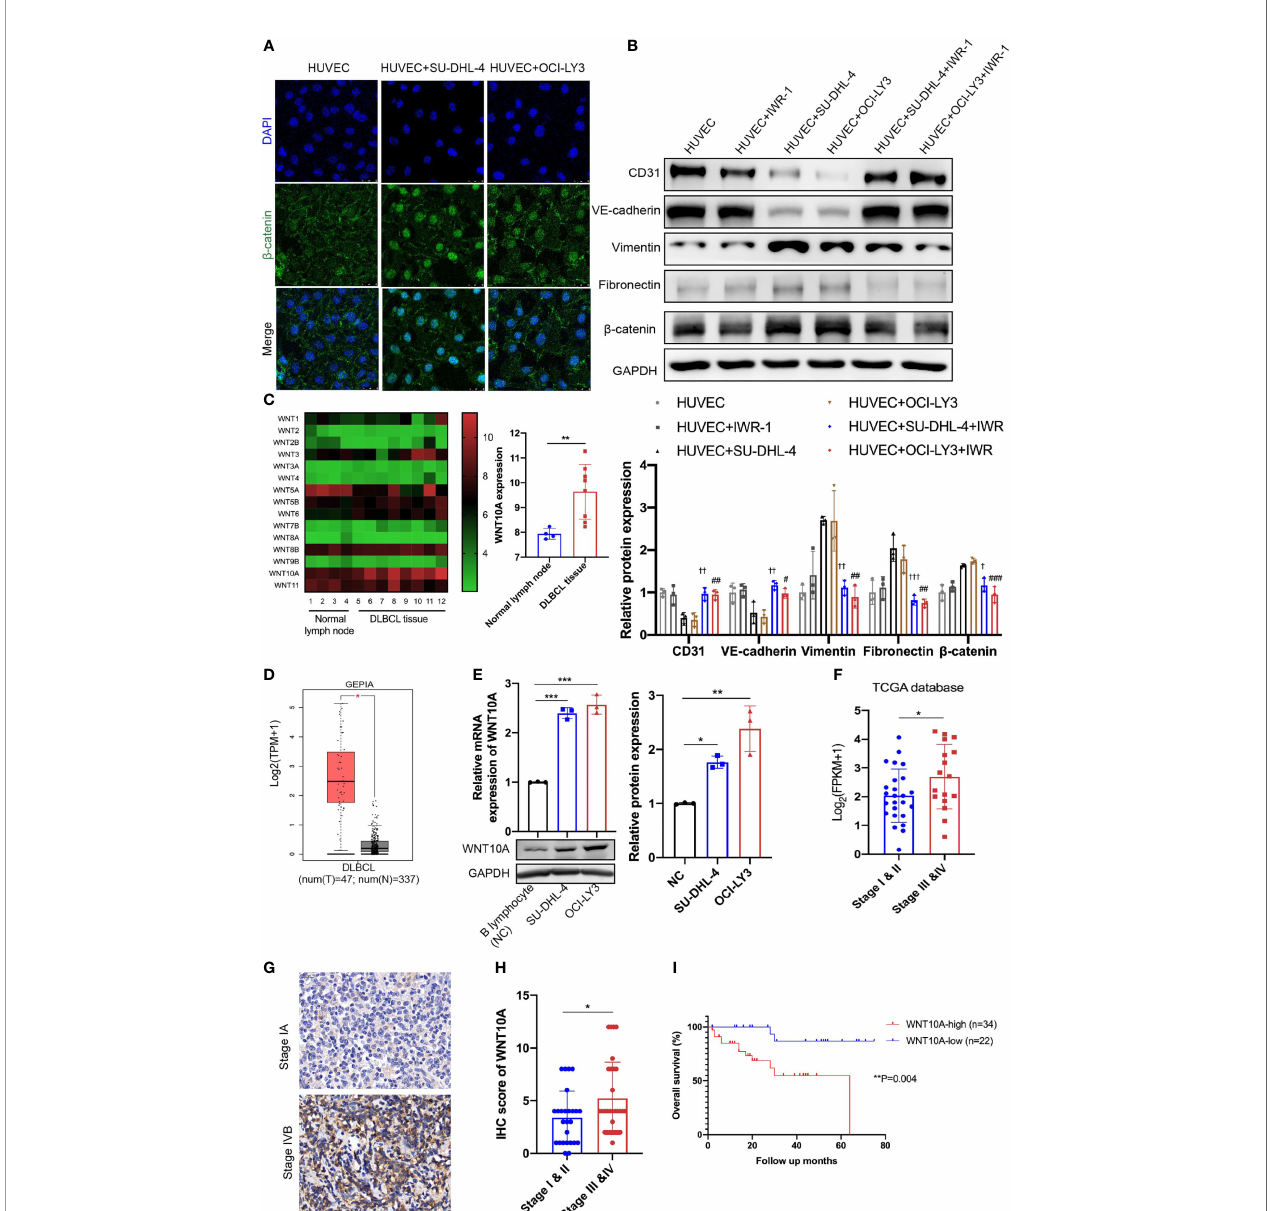
FIGURE 4 | Canonical WNT signaling was involved in DLBCL-induced EndMT and WNT10A overexpression in DLBCL was associated with advanced stage and poor overall survival. (A) The subcellular localization of b -catenin in HUVECs was examined by immuno fl uorescence assay, and representative images are shown (n = 3 independent experiments). Scale bar, 25 m m. (B) 20 m M IWR-1 (B) , an inhibitor of the canonical WNT signaling, was added into HUVECs followed by incubating with DLBCL cells for 48 h, and the lysates of HUVECs were detected for endothelial and mesenchymal markers using immunoblot (n = 3 independent experiments). (C) Expression levels of WNT family members in normal lymph nodes (n = 4) and DLBCL tissues (n = 8) were detected by microarray analysis (left panel). Statistical analysis of WNT10A expression between normal lymph nodes (n = 4) and DLBCL tissues (n = 8) (right panel). (D) Differential mRNA expression pro fi les of WNT10A in DLBCL tissues and normal tissues were shown in Gene Expression Pro fi ling Interactive Analysis database. (E) mRNA and protein expression of WNT10A in B lymphocytes from healthy donors and DLBCL cell lines were con fi rmed by qRT-PCR and immunoblot (n = 3 independent experiments). (F) High mRNA expression of WNT10A was correlated with advanced clinical stage in DLBCL according to The Cancer Genome Atlas (TCGA) database. Stage I and II (n = 25) and Stage III and IV (n = 17). (G) Representative immunohistochemistry staining of WNT10A in DLBCL tissues of early stage and advanced stage. Scale bar, 20 m m; n = 3 independent experiments. (H) Statistical analysis of WNT10A expression in DLBCL patients with different clinical stages. Stage I and II (n = 26) and Stage III and IV (n = 30). (I) Overall survival of DLBCL patients was analyzed by Kaplan – Meier analysis based on WNT10A expression. Error bars, SD; † p < 0.05, †† p < 0.01, ††† p < 0.001 vs. “ HUVEC+SU-DHL-4 ” ; # p < 0.05, ## p < 0.01, ### p < 0.001 vs. “ HUVEC+OCI-LY3 ” ; * p < 0.05, ** p < 0.01, *** p < 0.001 vs. control. DLBCL, diffuse large B-cell lymphoma; EndMT, endothelial-to-mesenchymal transition; HUVEC, human umbilical vein endothelial